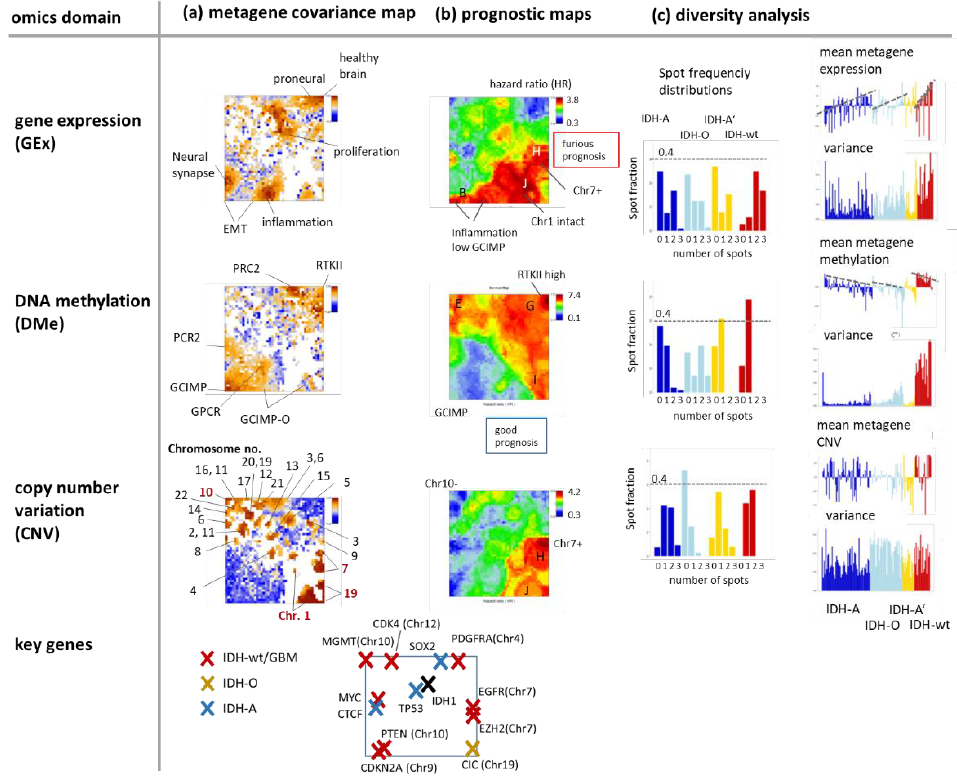
Figure 5. Characteristics of the omics domains: ( a ) The metagene covariance maps colour code the mean covariance between the single-gene profiles and the metagene profiles in each pixel. High covariance values (red) agree with the spot regions. They preferentially associate with cellular programs (Gex), methylation modes (Dme), and chromosome-wise aberrations (CNV). ( b ) The prognostic map colour codes the overall survival (OS) hazard ratio (HR, compared with the mean OS averaged over the whole data set) between maximum (red, furious prognosis) and minimum (blue, good prognosis) HR. HR values are calculated metagene-wise by selecting tumours showing omics scores exceeding one standard deviation in positive direction (i.e., with high values of the score, see [35] for details). ( c ) Diversity analysis includes spot frequency distributions and profiles of the mean omics score and variance per tumour. The row below maps the key genes driving the different genetic subtypes (see Discussion section).